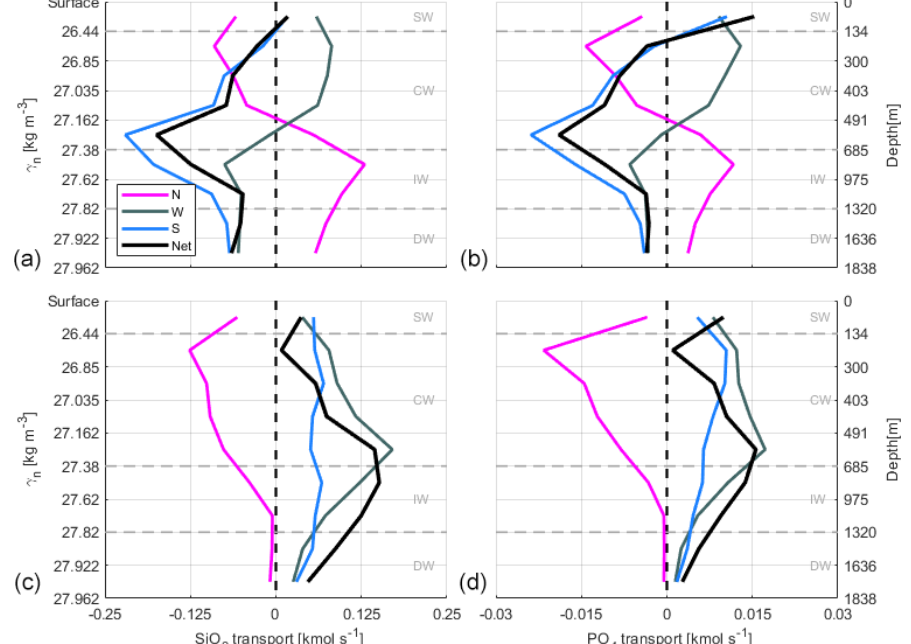
Figure 16. Accumulated SiO 2 and PO 4 transports (kmols − 1 ) at transects in the north (N, magenta line), west (W, dark grey line) and south (S, blue line) during fall (a, b) and spring (c, d) . See Table 2 for the γ n values bounding every water layer. Negative–positive values indicate inward–outward transports as in Fig. 12. The net transport in the whole box is shown by the black line.